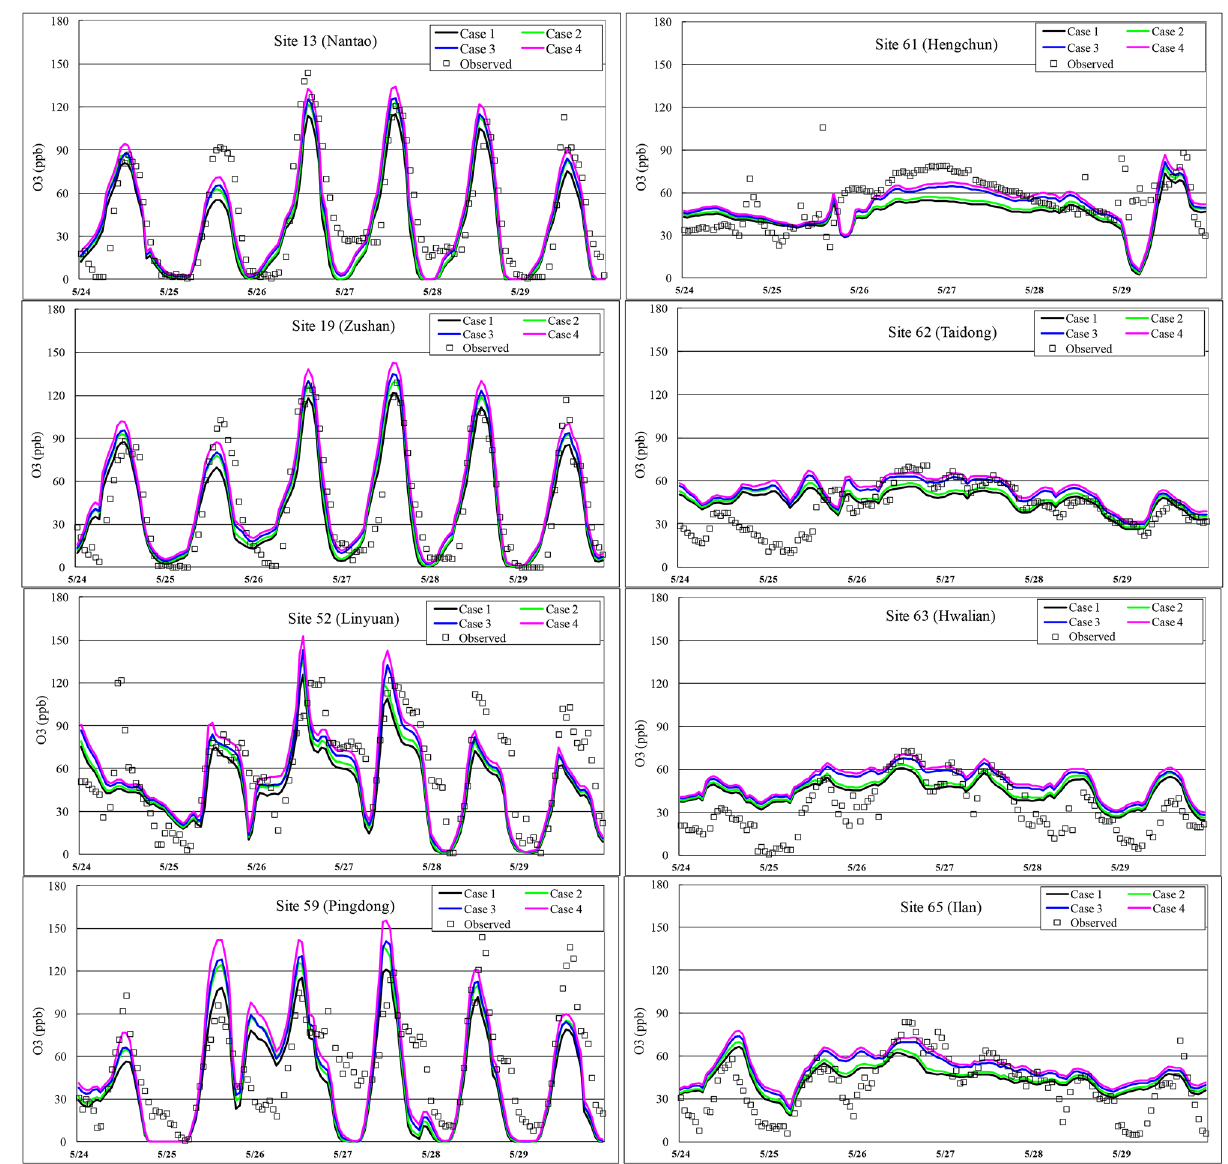
Figure 6. Time series of the simulated and observed ozone concentrations during the 6-d period from May 24 to 29, 2003, for Cases 1 to 4 at the stations in polluted areas (left side) and clean areas (right